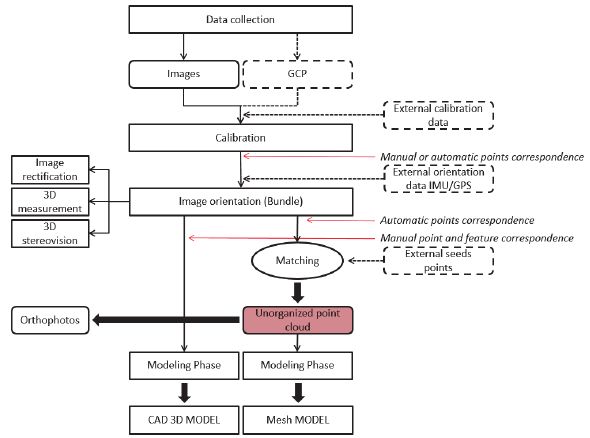
Figure 8: The Photogrammetric Pipeline valid both for the old and new way of making